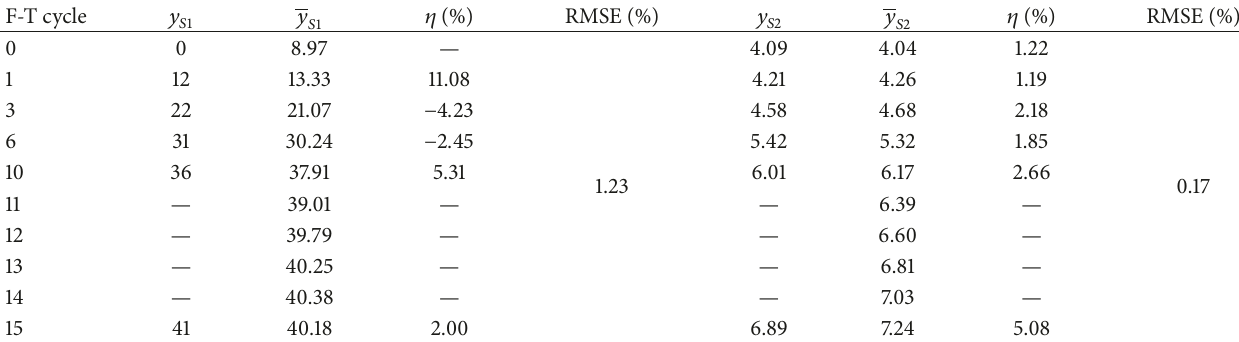
Table 12: Prediction results of 𝑦 𝑆1 and 𝑦 𝑆2 for CRSSMA based on regression model.